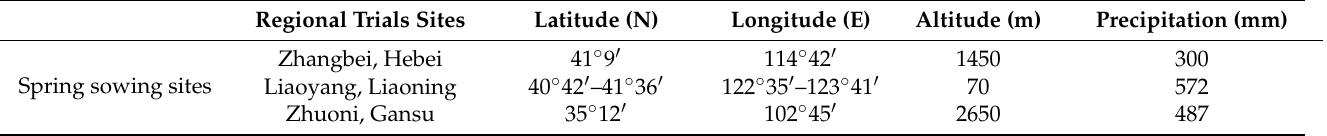
Table 1. The fourth round of regional trial sites of China pea cultivars in the spring sowing group and the winter sowing area